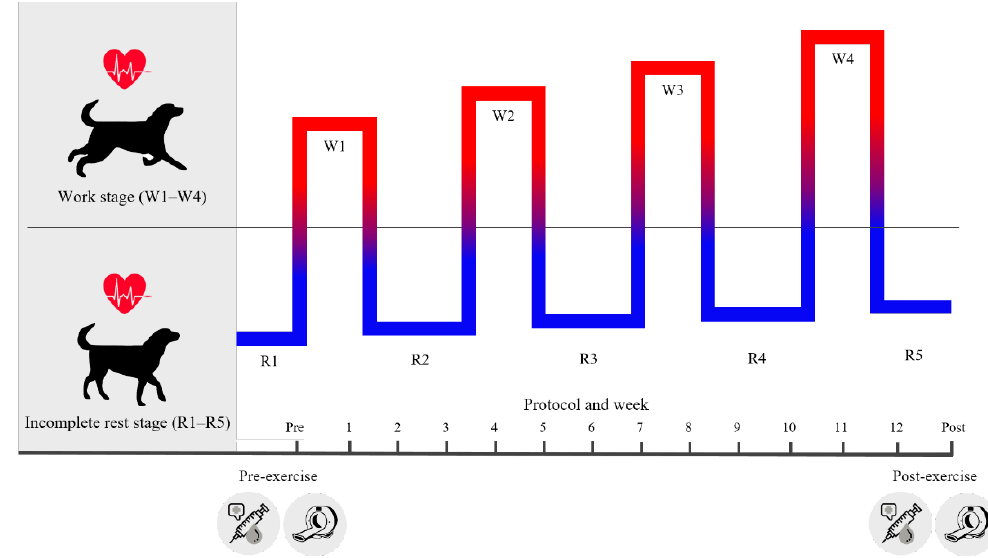
Figure 2. Schematic design of experimental procedures. Dogs underwent interval exercise comprising five resting stages and four workout stages over 12 weeks. Blood biochemical parameters (pre-exercise, post-exercise), heart rate (overall interval exercise), and QCT (pre-exercise, post-exercise) were measured for each dog.